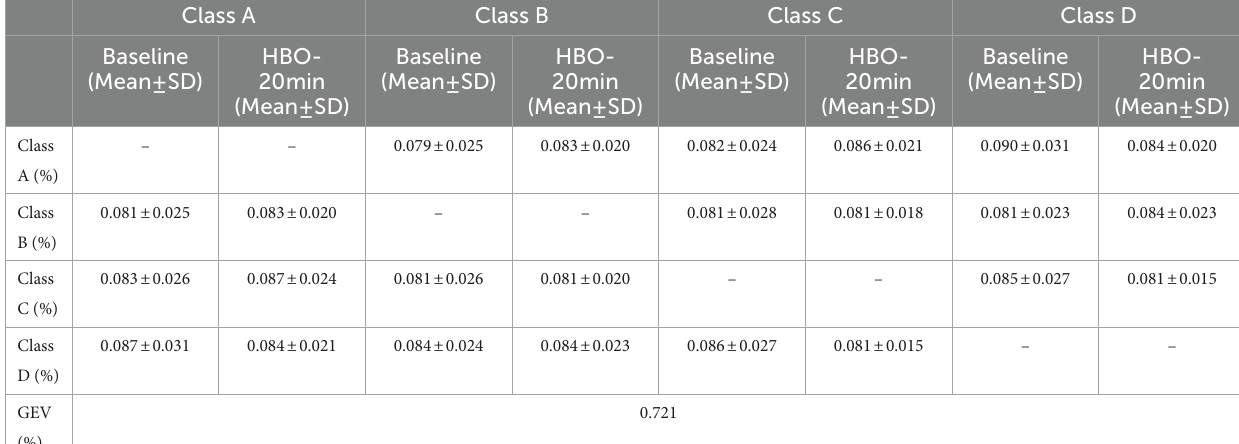
TABLE 3 EEG microstate transition probability and GEV analysis results of all DOC patients (41 cases).